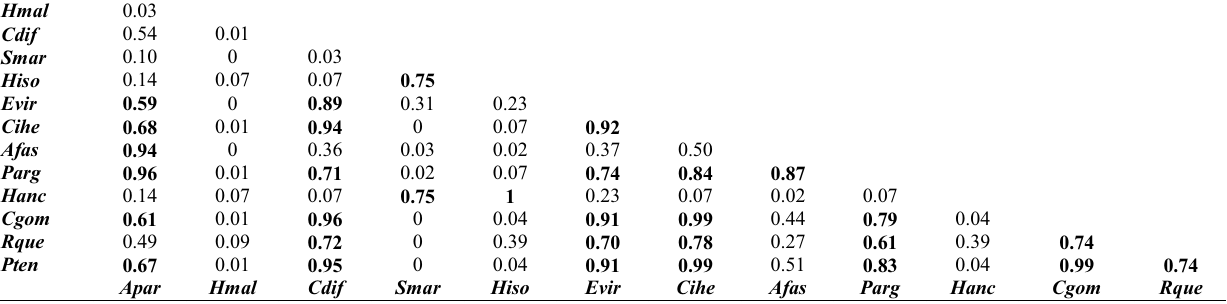
Table 3. Food overlap between 31 pairs of fish species of the Paulicéia stream. Values were considered significant when >